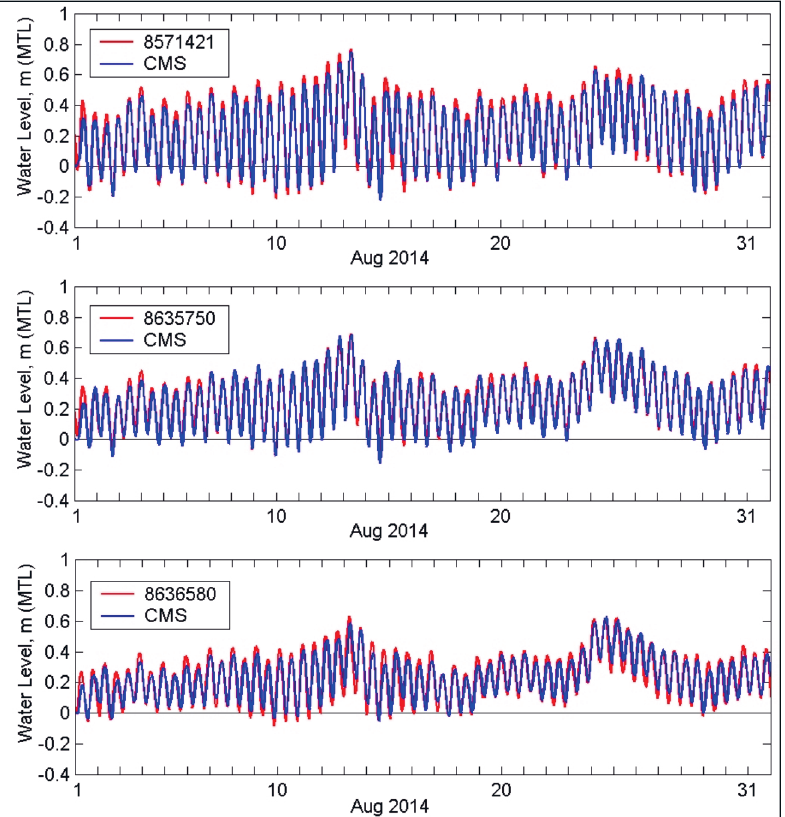
Figure 8. Model and measured water levels at Bishops Head, MD (8571421), Lewisetta, VA (8635750), and Windmill Point, VA (8636580) for August